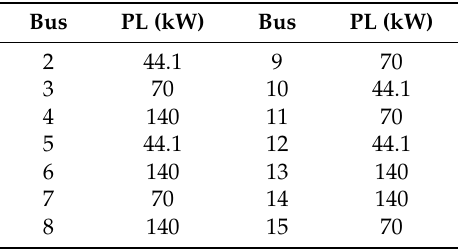
Table 1. IEEE 15 Bus System Load Data.